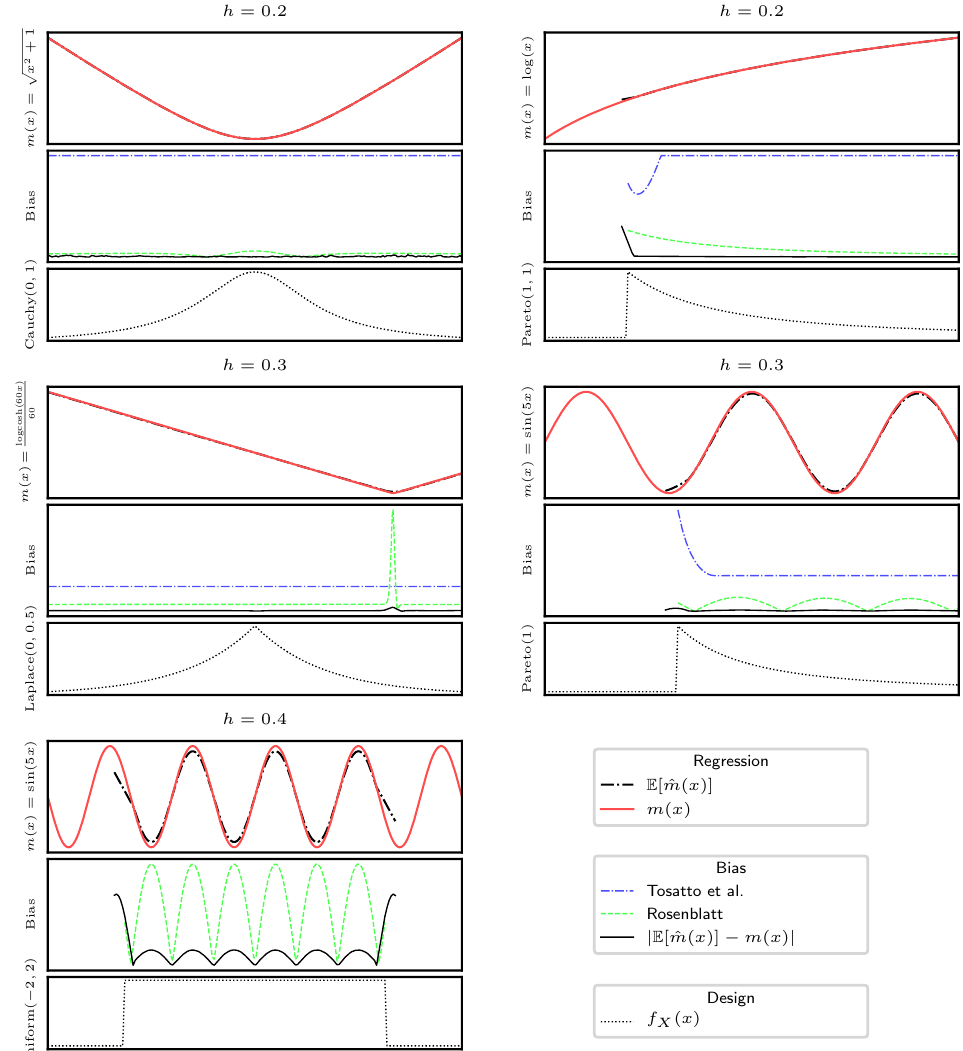
Figure A2. Same experiment as in Figure 1, with Box